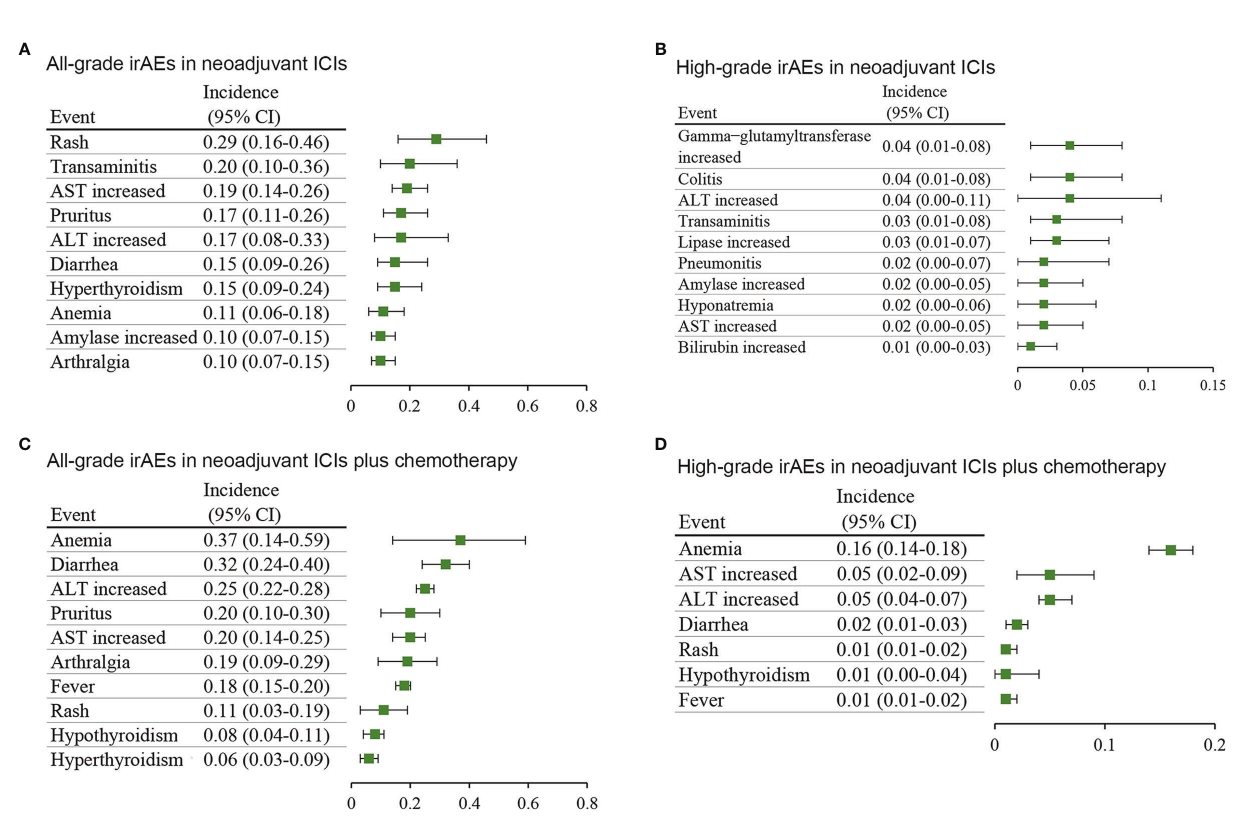
FIGURE 3 | Incidence of the most common immune-related adverse events in different treatment groups. (A) all-grade and (B) high-grade in neoadjuvant ICIs alone. (C) all-grade and (D) high-grade in neoadjuvant ICIs plus chemotherapy. AST, aspartate aminotransferase; ALT, alanine transaminase; CI, con fi dence